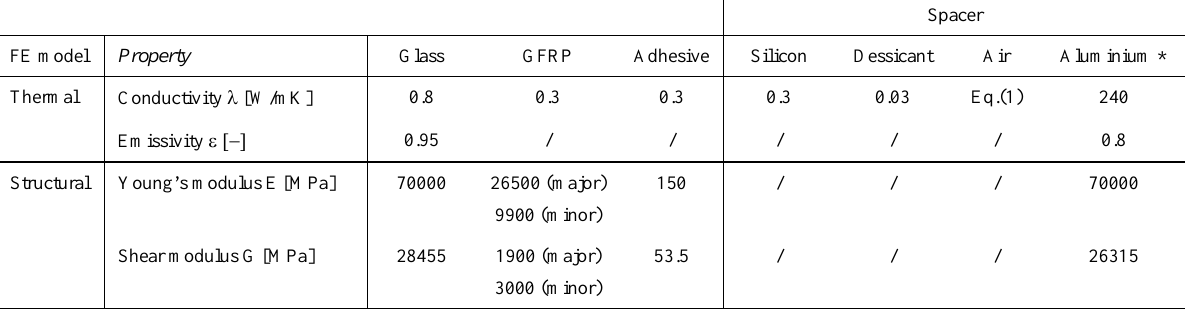
Table 2: Thermal and mechanical material properties for FE modelling (ABAQUS). * Material properties in use also for the non-integrated module with aluminium